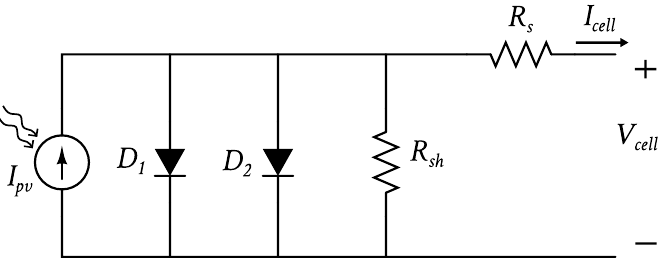
Figure 1. Double-diode solar cell model